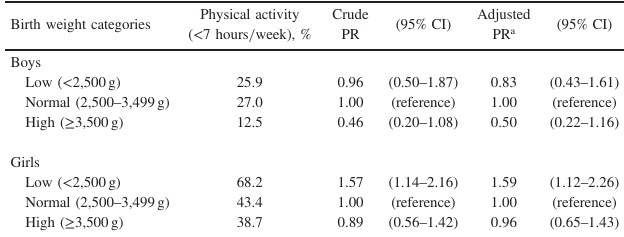
Table 2. Association between birth weight categories and not meeting the recommended physical activity at aged 9 – 15 years Birth weight